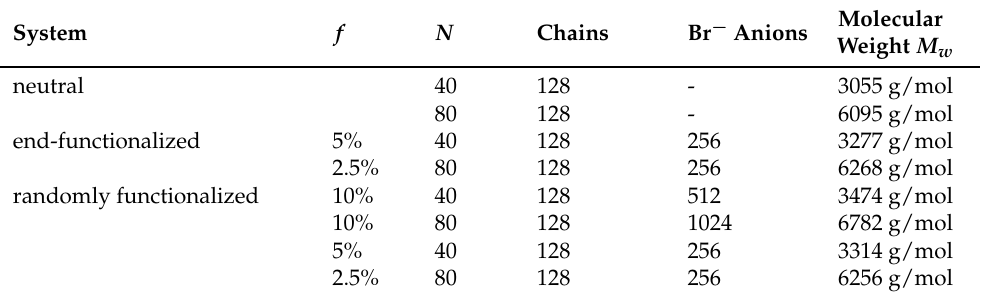
Figure 1. Chemical structures of poly(dimethylsiloxane). ( a ) neutral PDMS chain, ( b ) ionic PDMS chain functionalized on its chain ends, ( c ) ionic PDMS chain functionalized grafted randomly (random copolymer) along its backbone. The bromide (Br − ) counterions (anions) are dispersed in the melt. Table 1. Systems studied at T = 300 K, 375 K, 425 K, 450 K, and 473 K. The mass of Br − is about 80 g/mol, the excess mass of a N + -carrying side chain is ≈ 100 g/mol, the mass of a monomer is 74